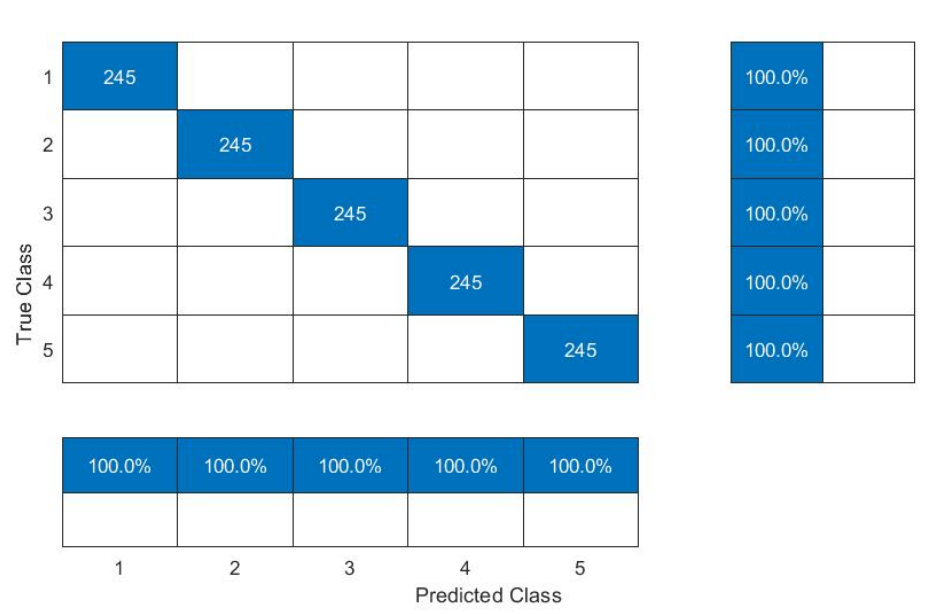
Figure 13. Confusion matrix: model trained at 3170 rpm and tested at 4955 rpm.